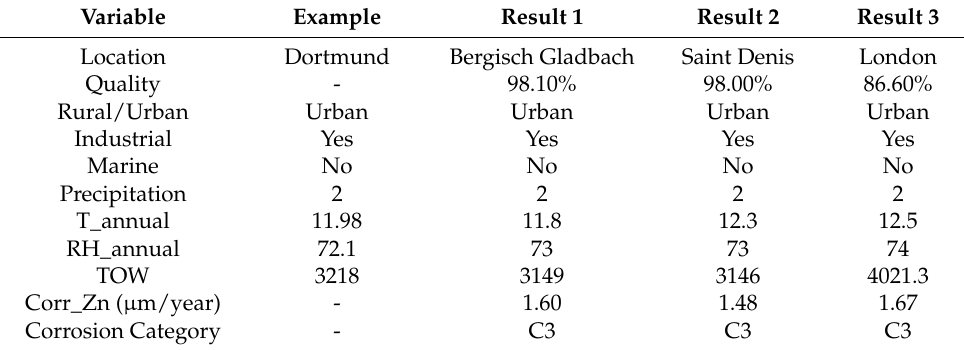
Table 7. Results of the example case, using the distance